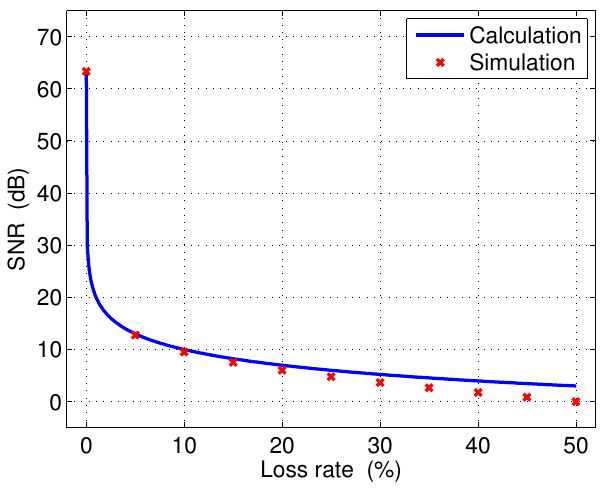
Figure 6. Comparison of estimated and simulated SNR